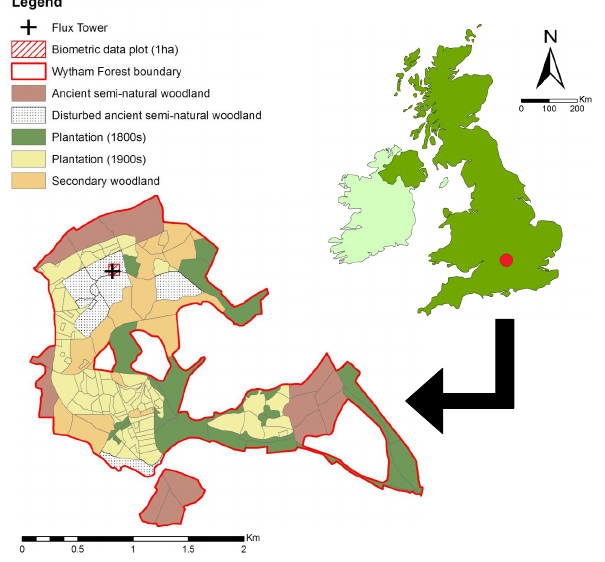
Fig. 1. Study site location in the UK and map of Wytham Woods showing woodland types, location of the flux tower and 1ha plot used for biometric data